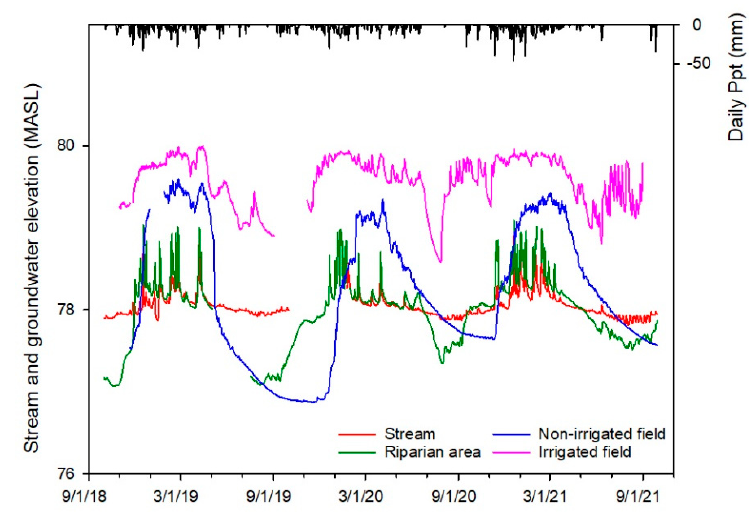
Figure 3. Seasonal surface water and shallow groundwater response to precipitation (Ppt) in three water years (2019 to 2021) at in-stream and various monitoring well locations at variable distance from Oak Creek’s mainstem near the OSU Dairy Center: a well in the riparian area 6 m north of the stream, a well in an irrigated field 160 m north of the stream, and a well in a non-irrigated agricultural field 90 m south of the stream. Irrigation season is typically July to September every year. Daily Ppt records obtained from https://agsci.oregonstate.edu/hyslop-weather-station (accessed on 30 January 2022).